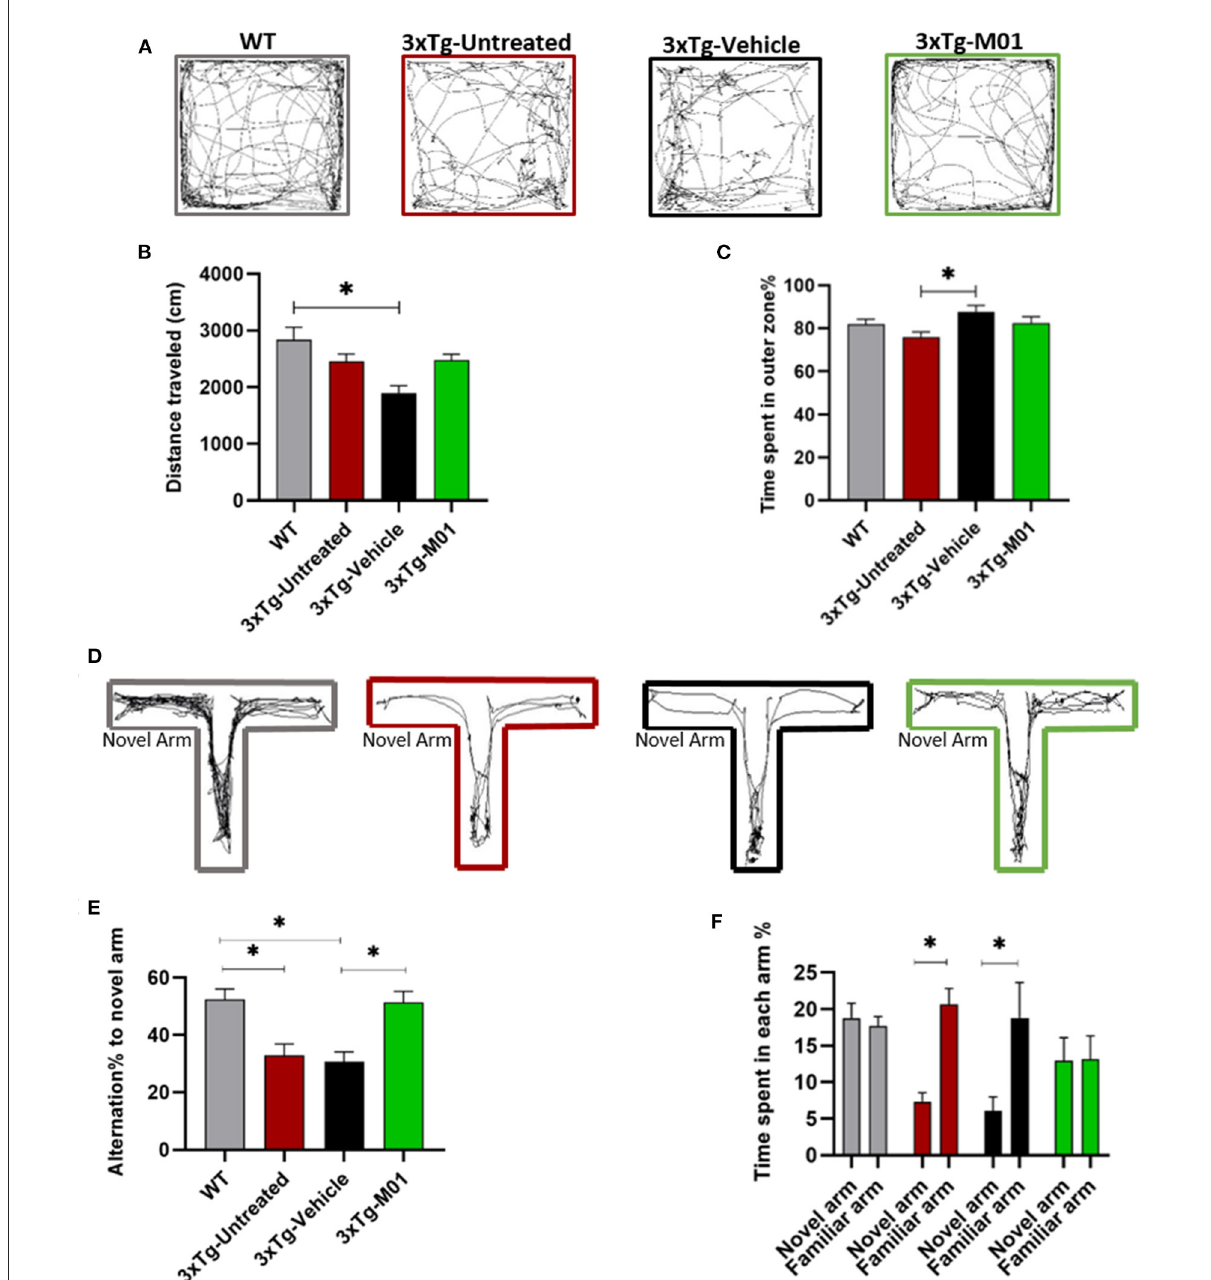
FIGURE1 M01 rescued working memory deficits in 3xTg-AD mice. (A) Trace diagram of mice in the OFT. (B) distance traveled in the OFT shows difference between WT and 3xTg-vehicle group, and no statistical difference between 3xTg-M01 group. (C) Time spent in the outer zone by each group of mice shows significant difference between 3xTg- untreated and vehicle group but not with the other groups (D) Trace pattern of all the groups in the T-maze paradigm. (E) Quantification data represent the percentage of alternation frequency toward the novel arm. Statistical difference was observed between WT and 3xTg- untreated, vehicle groups. M01 treated 3xTg mice shows high alternation toward novel arm compared to 3xTg-Vehicle group. (F) Percentage of time spent in the novel and familiar arms. 3xTg-untreated and vehicle groups spent significantly more time in the familiar arm while WT and M01 groups explored both the arms equally. Data are expressed as the mean ± SEM. * p < 0.05, n = 9–15/group, and one-way ANOVA followed by Tukey’s test were used to compare between